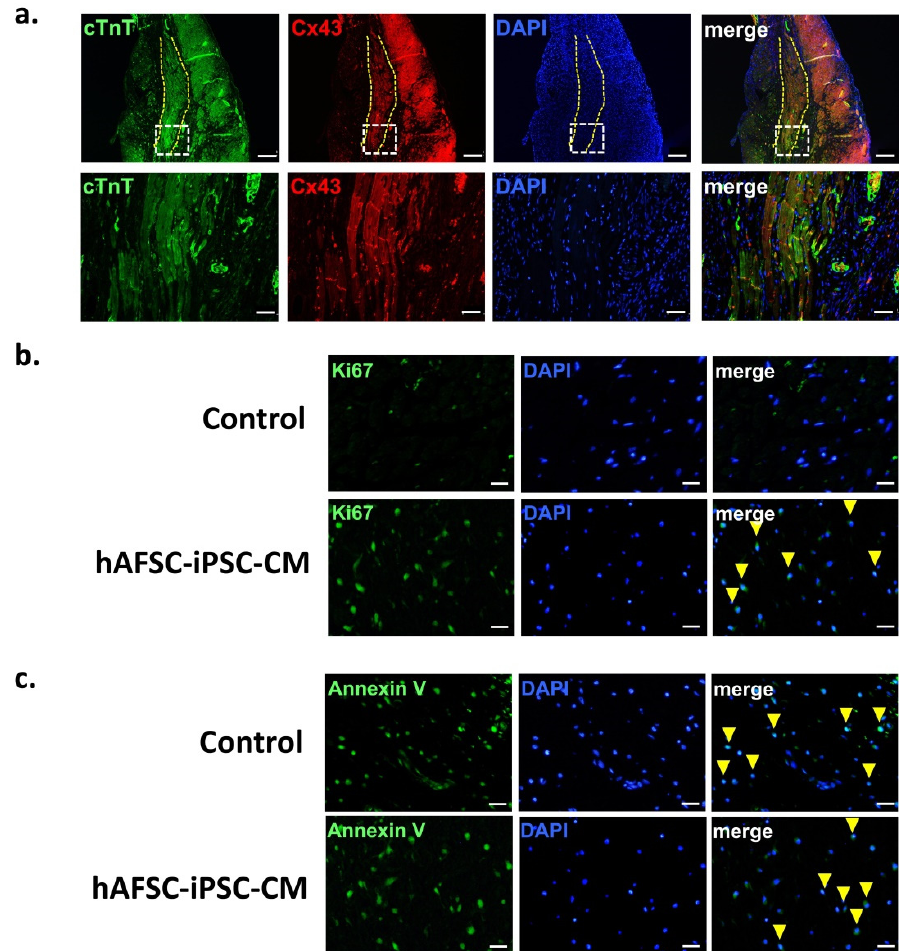
Figure 5. Graft integration, proliferation and apoptosis. ( a ) The infarcted region (dashed line) was remuscularized with hAFSC-iPSC-CM graft. Connexin 43 (Cx43) expression was detected at post-transplant 21 days (upper panel). The transplanted cardiomyocytes at the edges of grafts (lower panel, the magnified image of region boxed in the upper panel) showed Cx43-positive gap junctions between the graft and host. Confocal immunofluorescence scale bar, 50 µm (upper panel) and 200 µm (lower panel). ( b ) Proliferation of 3-week hAFSC-iPSC-CM graft was demonstrated by staining for Ki67 (green). Those cardiomyocyte nuclei in proliferation were indicated by arrowhead. Scale bar, 50 µm. ( c ) Apoptosis at post-transplant 3 weeks was demonstrated by staining for annexin V (green, arrowhead). Scale bar, 50 µm.